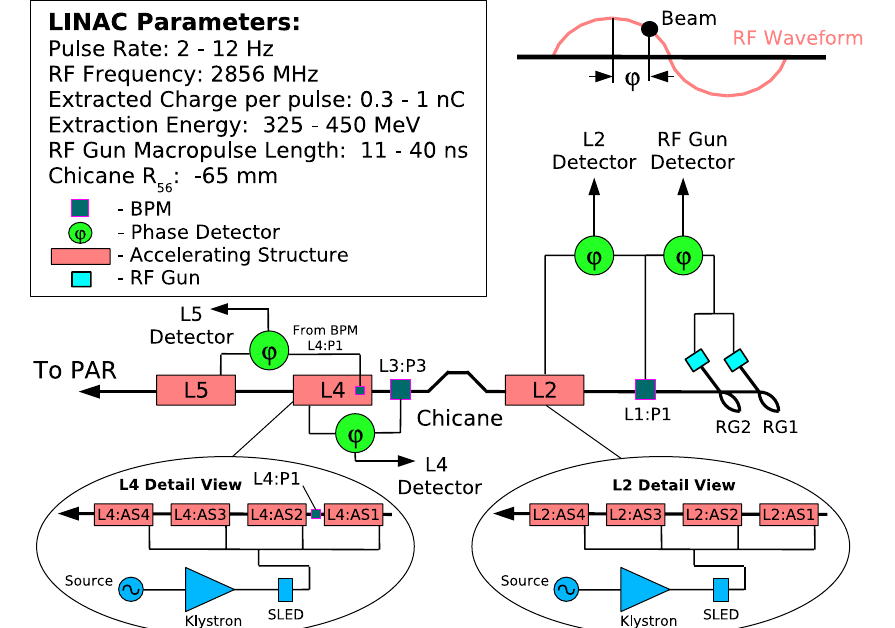
FIG. 1. (Color) Schematic of the APS linac with locations of the phase detectors labeled according to the rf system to which they attach (rf gun, L2, L4 and L5). Linac rf systems L2, L4, and L5 have a common source, klystron, and SLED configuration as shown in the bubble below systems L2 and L4. Phase detectors for systems L2, L4, and L5 are configured to take the rf signal from the ‘‘:AS1’’ accelerating structure. Beam position monitor L1:P1 is shared between the rf gun and L2 phase detector; BPMs L3:P3 and L4:P1 (within the L4 accelerating sector as shown) are used by the L4 and L5 phase detectors,